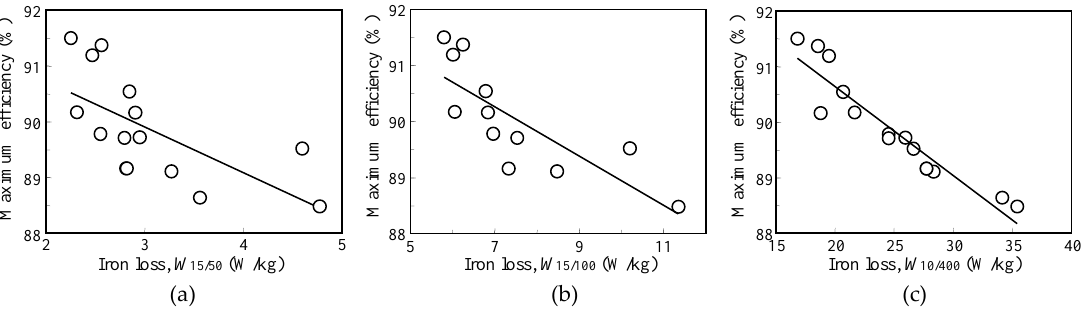
Figure 2. Relationship between maximum motor efficiency and iron loss W 15/50 , W 15/100 , W 10/400 . ( a ) Relationship between maximum motor efficiency and material iron loss at B = 1.5 T, 50 Hz; ( b ) relationship between maximum motor efficiency and material iron loss at B = 1.5 T, 100 Hz; ( c ) relationship between maximum motor efficiency and material iron loss at B = 1.0 T, 400 Hz.